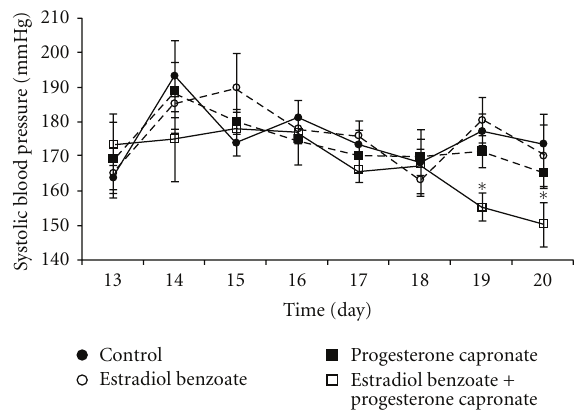
Figure 6: Changes of daily SBP in SHRs during middle and late pregnancy under administration of sex steroids and olive oil (control). Only E with P administration reduced significantly SBP at late pregnancy compared with those in others (at days 19, 20). ∗ P < .